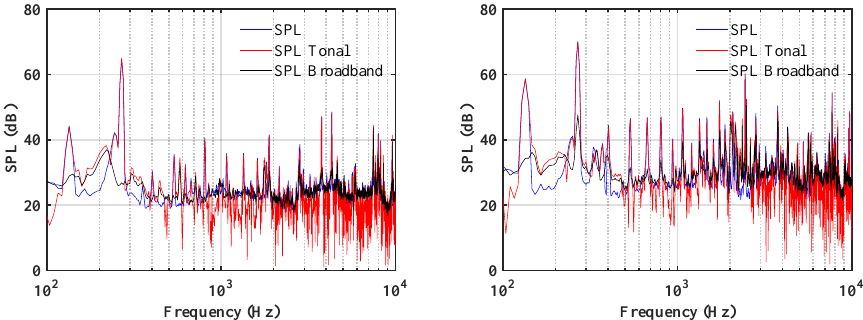
Figure A1. Total, tonal and broadband noise spectra: ( left ) isolated rotor; ( right ) twin rotors. The OASPL can now be computed by integrating the separated spectra to retrieve the directivities of each contribution. For the co-rotating case, Figure A2 illustrates the OASPL at each microphone for the three relative distances analyzed, t = 0.04 D , t = 0.16 D , t = 0.24 D , and the comparison with the isolated rotor configuration at 8000